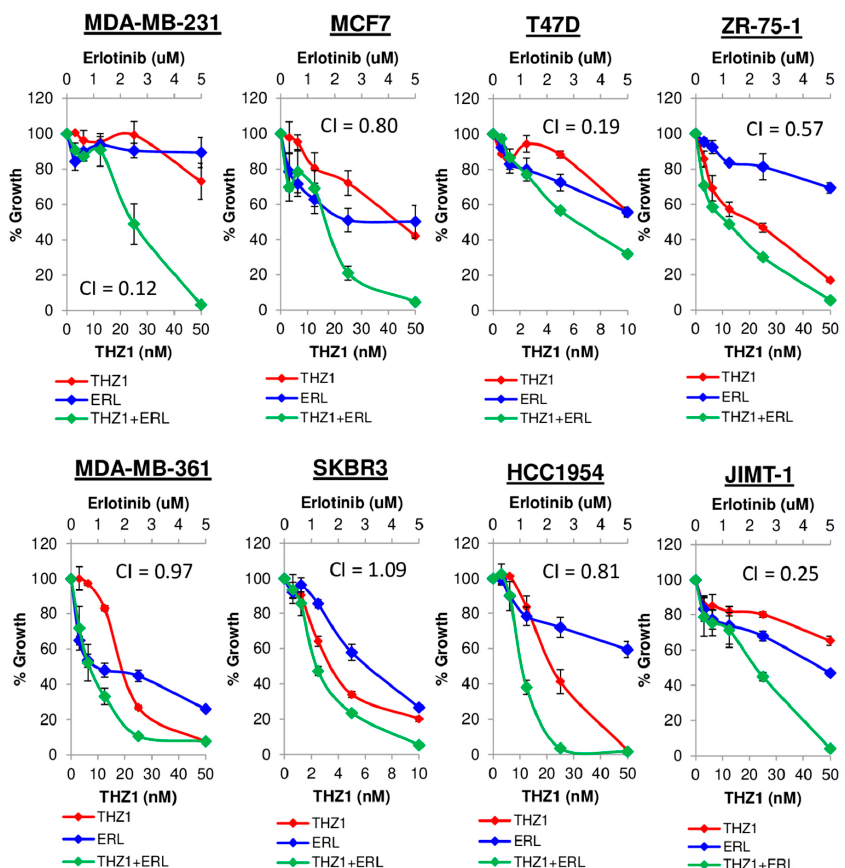
Figure 10. Dual inhibition of EGFR and CDK7. Cell growth curves for cell lines treated with low-dose THZ1 (0–50 nM) alone and in combination with erlotinib (0–5 µM) in fixed ratio combinations for 7 days.